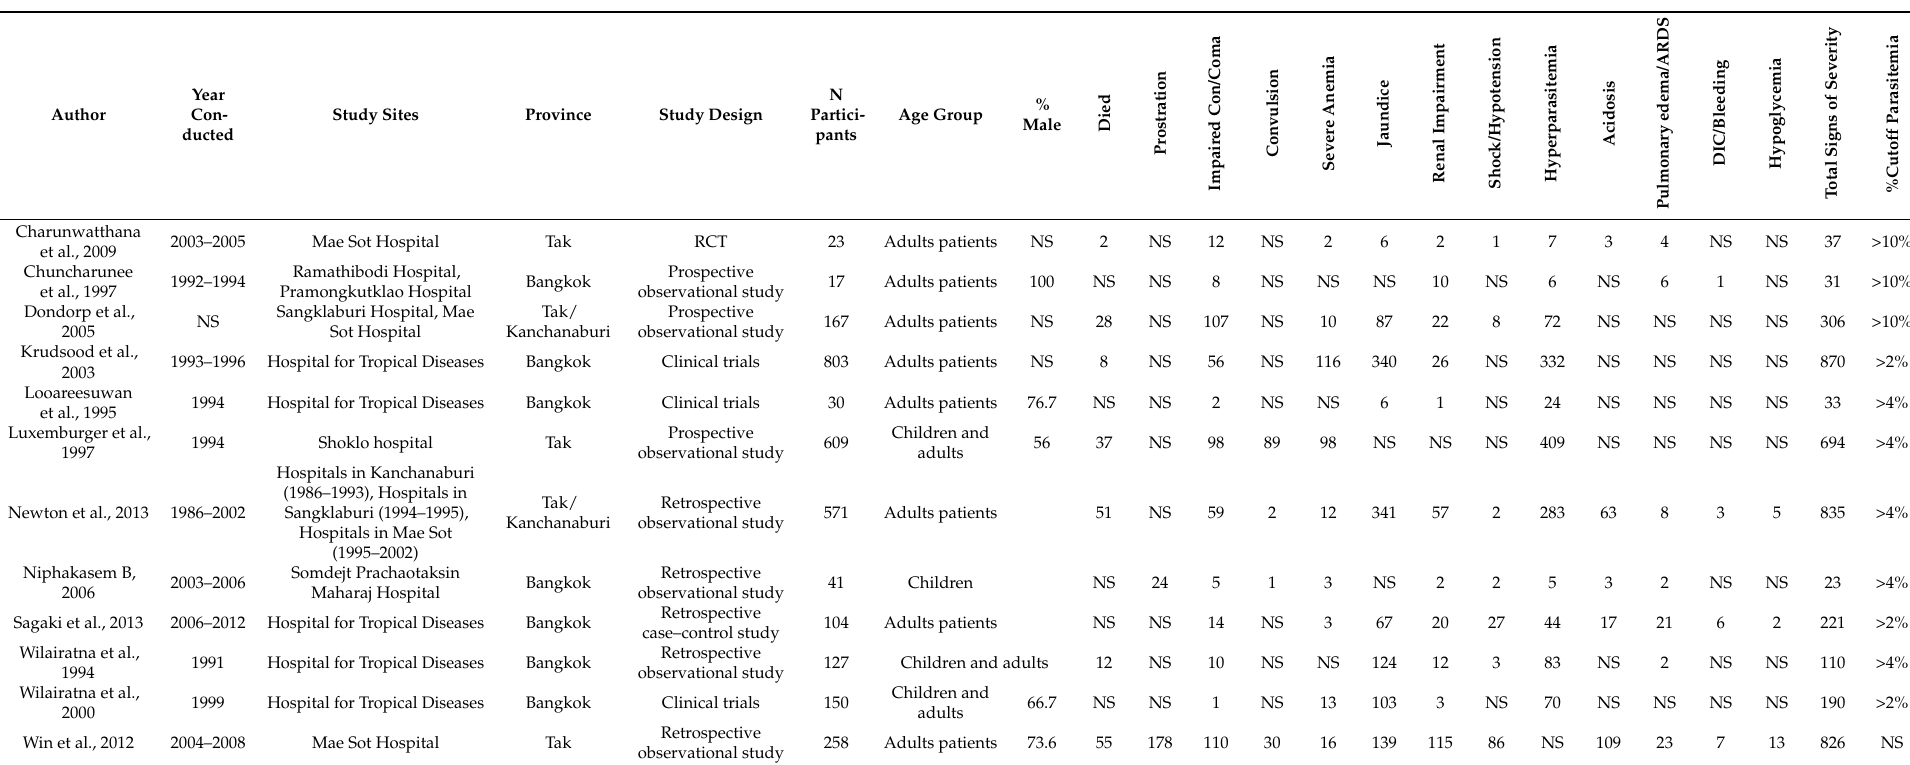
Table 1. Characteristics of the included